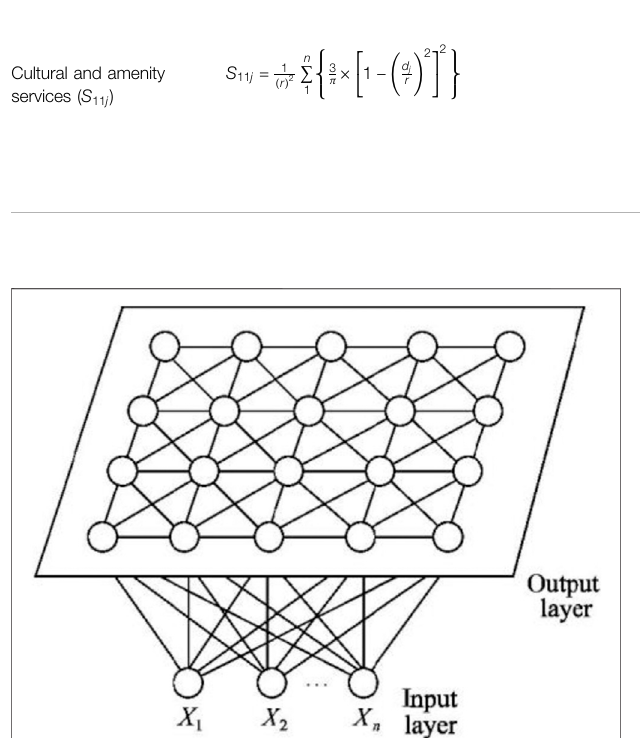
FIGURE 3 | Topological structure of